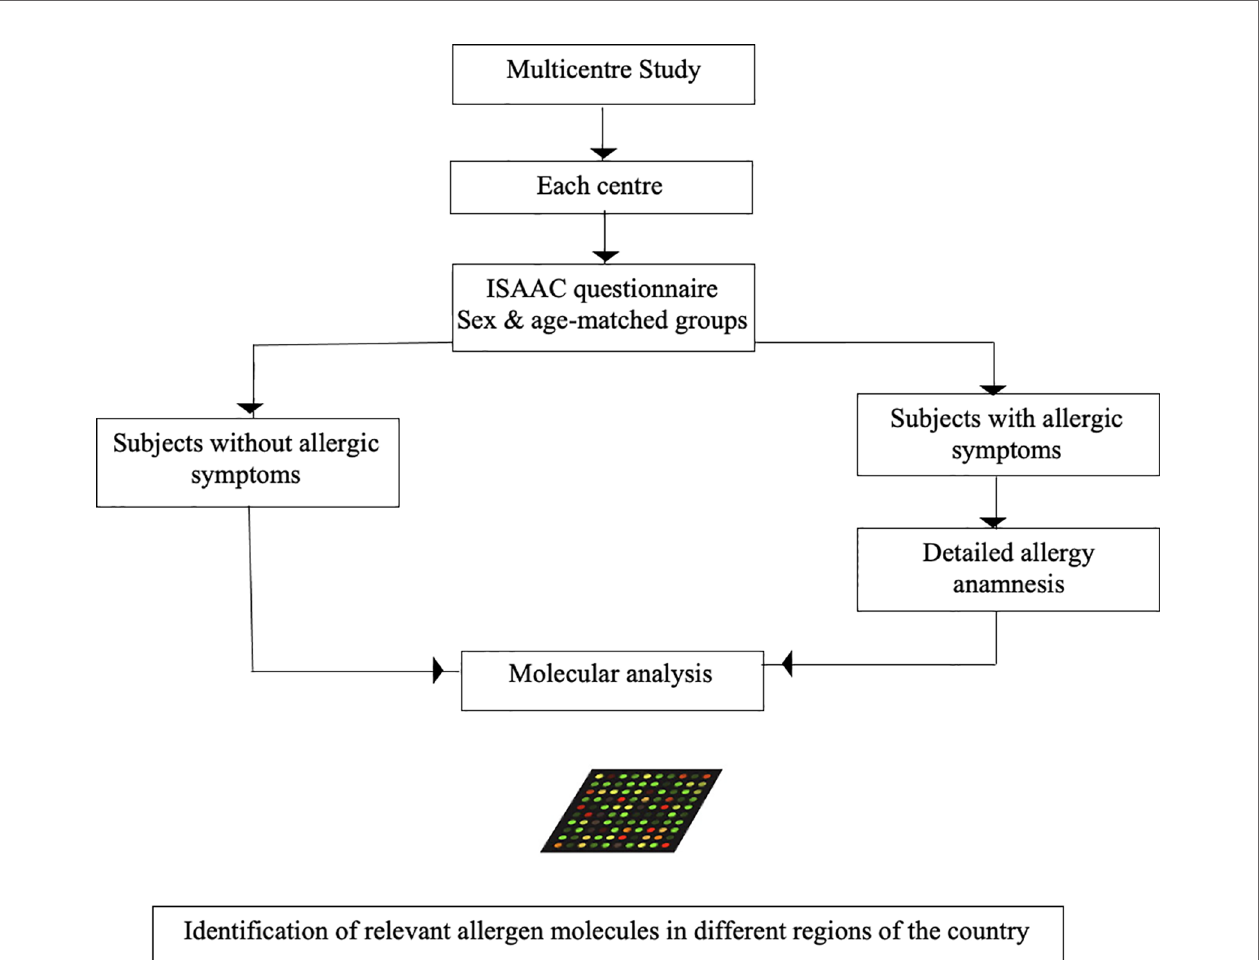
FIGURE 8 | Possible design of a multicenter study to determine the relevant allergen molecules in the different regions of China. Sex- and age matched groups of equal number with or without allergic symptoms according to ISAAC questionnaire are obtained from the regional population of each center. In subjects with allergic symptoms a detailed anamnesis of allergic symptoms is performed. Sera from the subjects with and without allergic symptoms are then analyzed in an anonymized and blinded manner to determine the molecular IgE sensitization pro fi les in a qualitative (i.e., nature of IgE-positive allergens) and quantitative (i.e., allergen-speci fi c IgE levels) manner to de fi ne the relevant allergen molecules in each region of the